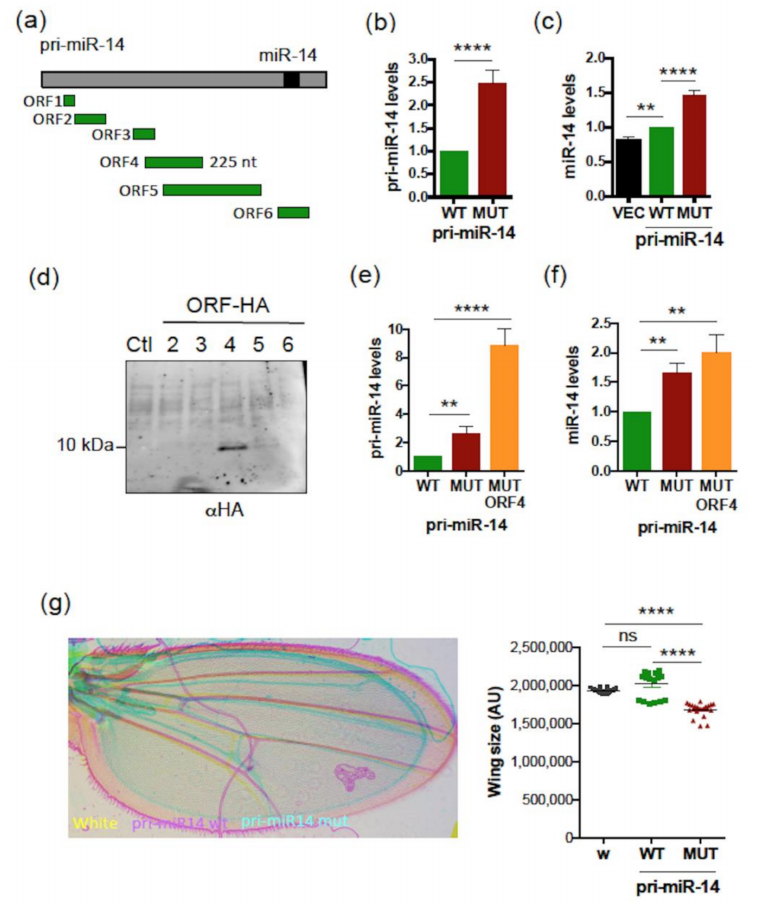
Figure 7. Drosophila pri-miR-14 contains smORFs regulating its expression and activity. ( a ) Schematic structure of Drosophila pri-miR-14 with the miR-14 (black box) and the six smORFs (green box) indicated. ( b ) Relative expression levels of pri-miR-14 WT or all ATG-mutated (MUT) transfected into S2 cells and determined by qRT-PCR. Pri-miR-14 levels were normalized as in Figure 4b. Data are means ± S.E.M. n = 14. ( c ) Relative expression levels of miR-14 from control vector (VEC) or WT or MUT pri-miR-14 transfected S2 cells and determined by qRT-PCR. MiR-14 levels were normalized as in Figure 4c. Data are means ± S.E.M. n = 15. ( d ) Translatability of pri-miR-14. Pri-miR-14 constructs with the smORFs fused to the HA tag were translated in vitro and analyzed by western blot. Translation of the smORF was detected with an anti-HA antibody. ( e ) Relative expression levels of WT or MUT or ORF4 ATG-mutated (MUT ORF4) pri-miR-14 transfected in S2 cells and determined by qRT-PCR. The pri-miR-14 levels were normalized as in Figure 4b. Data are means ± S.E.M. n = 15. ( f ) Relative expression levels of miR-14 processed from WT or MUT or MUT ORF4 pri-miR-14 transfected in S2 cells and determined byRT-PCR analyses. The miR-14 levels were determined as in Figure 4c. Data are means ± S.E.M. n = 10. ( g ) Activity of WT or MUT pri-miR-14 on wing size. The WT or MUT pri-miR-14 constructs were expressed in wings using the MS1096 driver and the phenotypes scored on wing size. Left panel: representative wings are shown. Right panel: quantification of the wing size. AU: Arbitrary Unit. Data are means ± S.E.M. from 19 wings analyzed for control (white, w), 18 for WT pri-miR-14 and 19 for MUT pri-miR-14. ** p < 0.01, **** p < 0.0001, ns: not